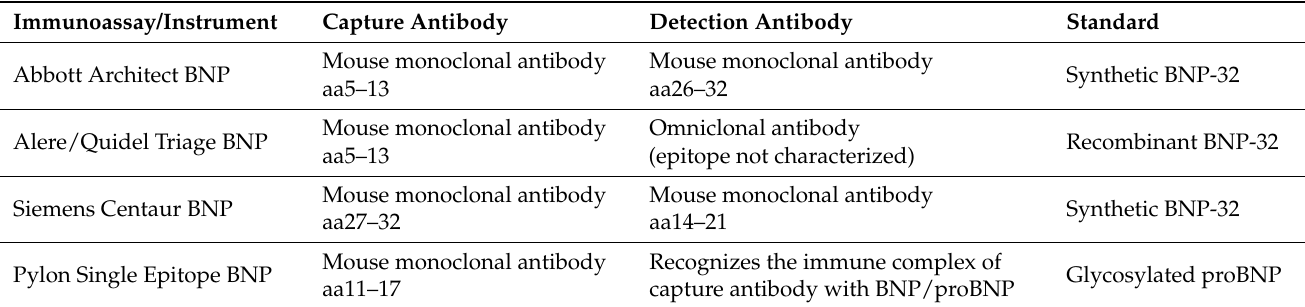
Table 1. Types of antibodies and amino acid recognition sites for various BNP assay